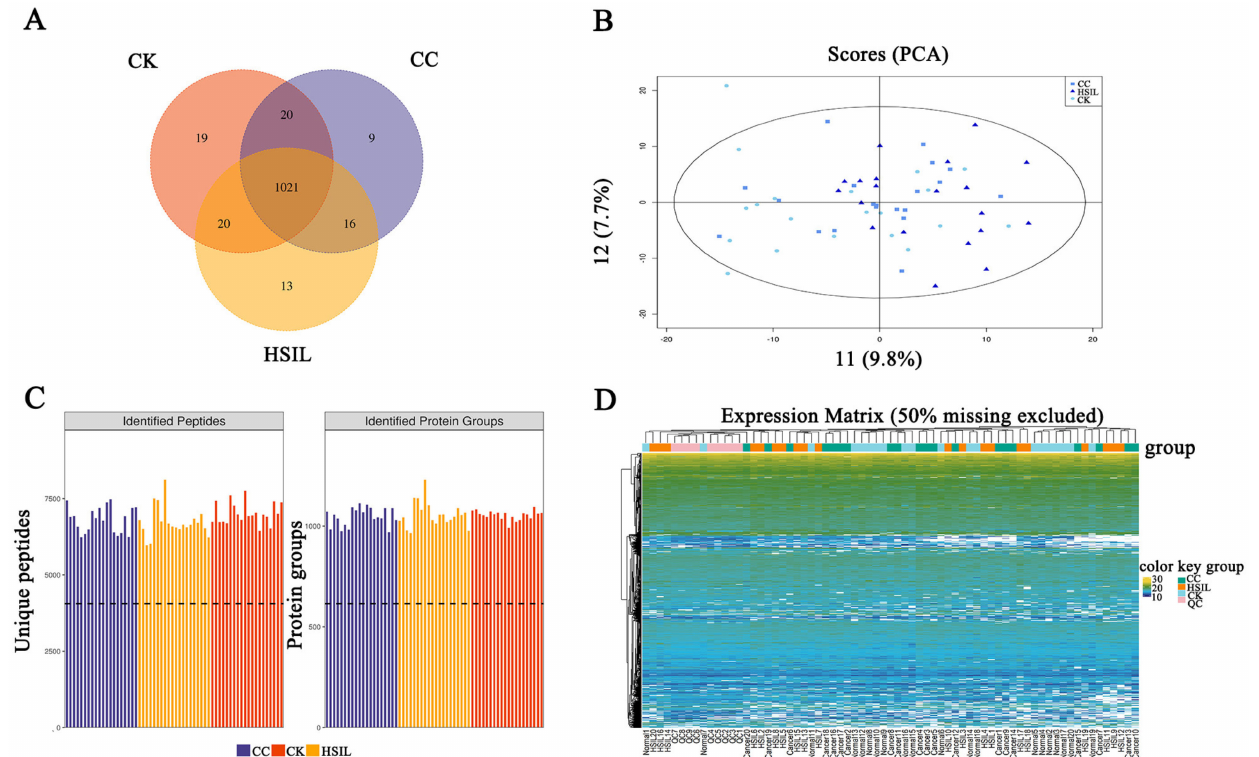
Figure 2. General overview of protein identification. ( A ) Venn diagram showing the number of pro- teins common and unique to healthy, HSIL and cervical cancer patients; ( B ) PCA score plot. Samples from the CK (n = 20), HSIL (n = 20) and CC (n = 20) groups are plotted along the three principal com- ponent. ( C ) The identified peptides and protein of the three groups. ( D ) DIA quantitative heat map of total protein. Protein expression levels are shown in different colors, with yellow indicating a stronger signal, dark blue indicating a weaker signal, and white indicating no quantitative